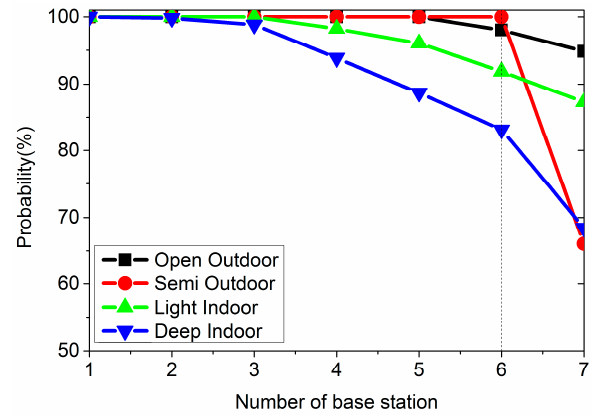
Figure 5. The probability curve of the number of GSM cellular base stations.